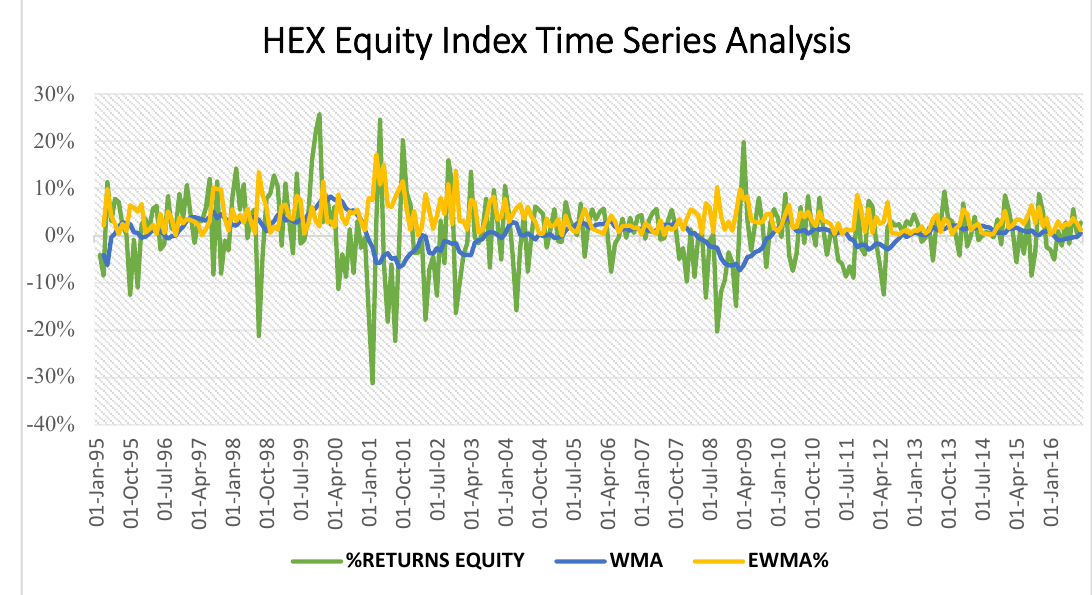
Figure 7. HEX monthly time series analysis, equity. Source: authors. The time series in Figure 8 is different from the other equity returns, as it generally has a stable volatility, centring on the mean and fewer spikes during the 1997 Asian crisis, which could be because of the impact of Asian investors to the African nation being affected. It was not really affected by the tech bubble, implying that most of its investors were probably not in the tech industry. The WMA is generally more stable and smoothed out.